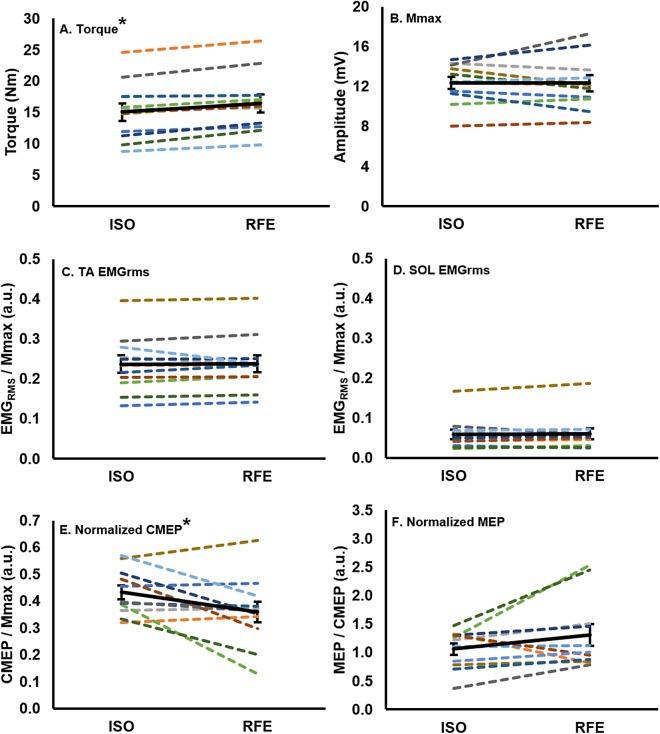
Mean values for each participant and the group mean.Mean values for each participant (colored lines) and the group (n = 11) mean (black line; error bars indicate standard error of the mean) in the RFE and ISO states. Each participant maintains the same color across all graphs. There was a ∼10% increase in torque (A), and a ∼17% decrease in normalized CMEP (E) in the RFE state when compared with the ISO state (*p < 0.05). There was no significant difference in EMGRMS recorded from the tibialis anterior (C) or soleus (D), Mmax (B), or normalized MEP (F) between the two states (p > 0.05).